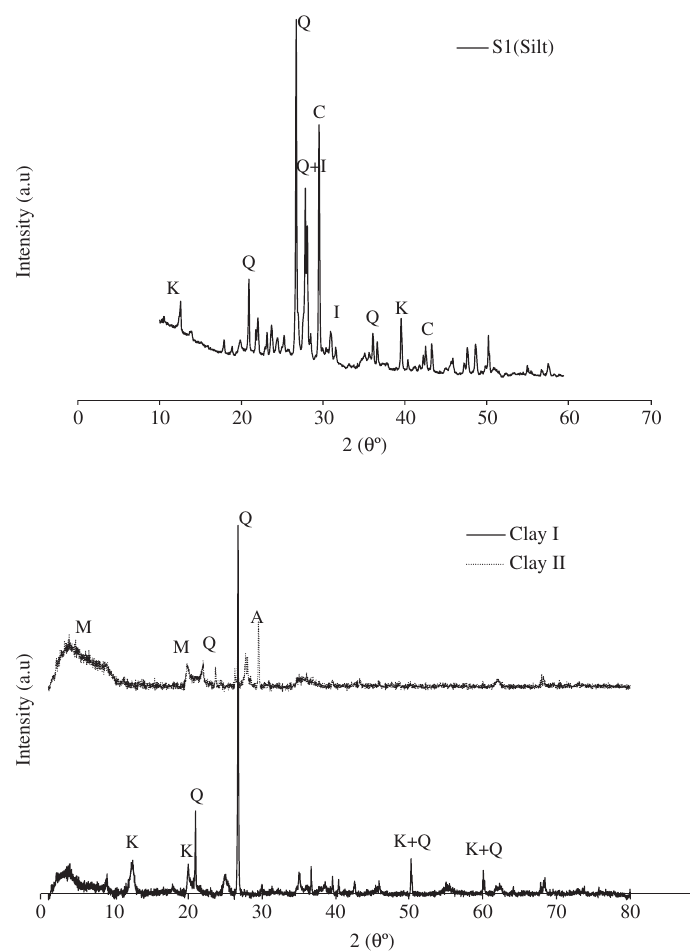
Figure 1 X-ray diffraction patterns of silt and clays. I, Illite; Q, quartz; C, calcite; K, kaolinite; Q, quartz; M, montmorillonite; A, anorthite.